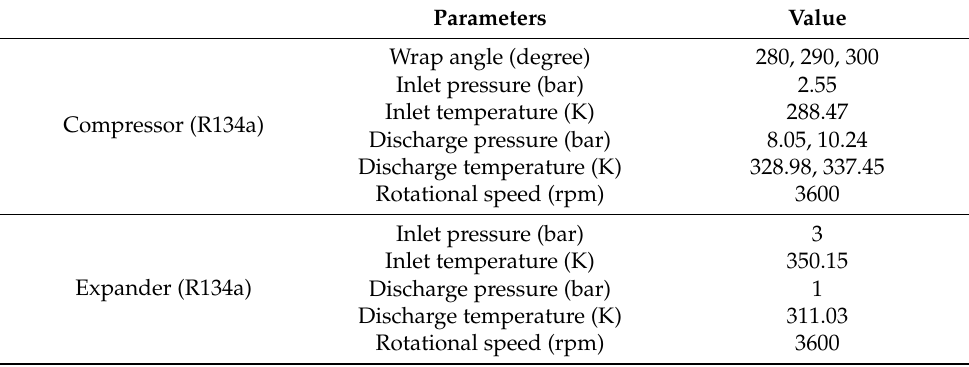
Table 2. Boundary